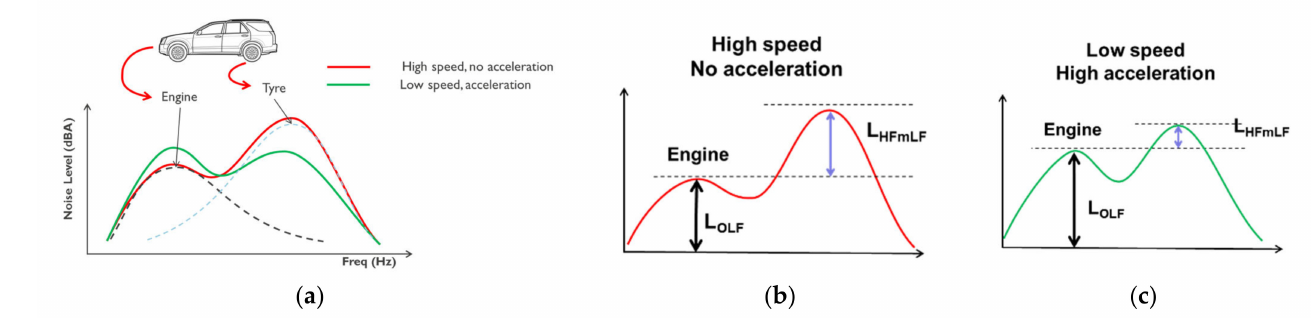
Figure 1. ( a ) Visualization of the spectral content of engine and tyre noise for two situations, high and low speed. ( b ) The two noise parameters, engine noise and cruising noise for a high-speed traffic situation. ( c ) The two noise parameters for a low-speed traffic situation with